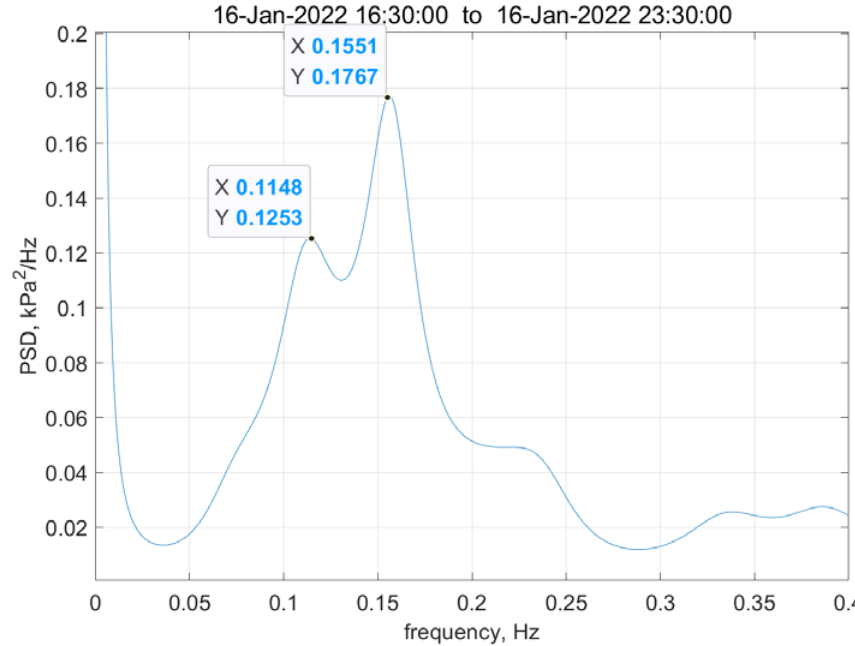
Figure 18. PSD of differential pressure